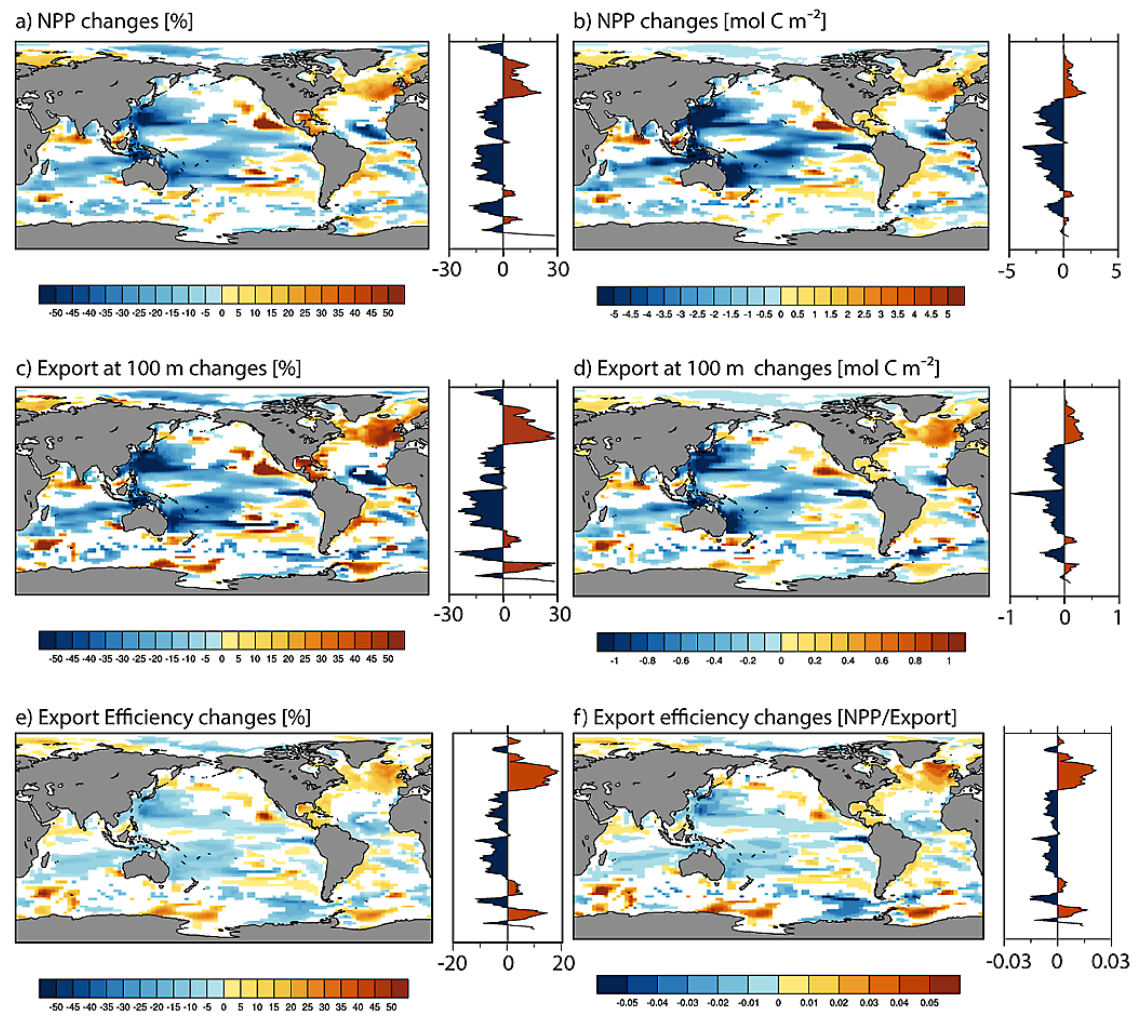
Fig. 1. Simulated changes in net primary production ( a and b ), particle export production ( c and d ) and export efficiency ( e and f ) from 1960 to 2006. The small panels to the right of each map show the zonal mean of the respective map using the same unit. Changes have been calculated using a linear regression on annual mean model output. Areas with insignificant changes ( p value of the regression is less than 0.05) are shown in white color. More details on calculation of trends are given in Sect. 2.5. Both total changes and changes in percent are given over the 47yr of the simulation (not %yr − 1 ). Export efficiency is the fraction of primary production that is exported through 100m, calculated by dividing the particle export production at 100m by integrated net primary production above